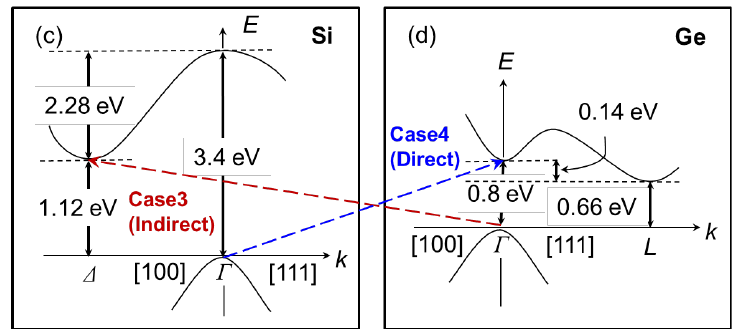
Figure 3. ( a ) Energy band diagrams for comparing Case2–Case4 at off-state ( V GS = 1.5 V, V DS = 0.95 V). ( b ) Indirect tunneling, direct tunneling and total I D of Case3 and Case4 structure. ( c ) Schematic energy band of Si. ( d ) Schematic energy band of Ge.